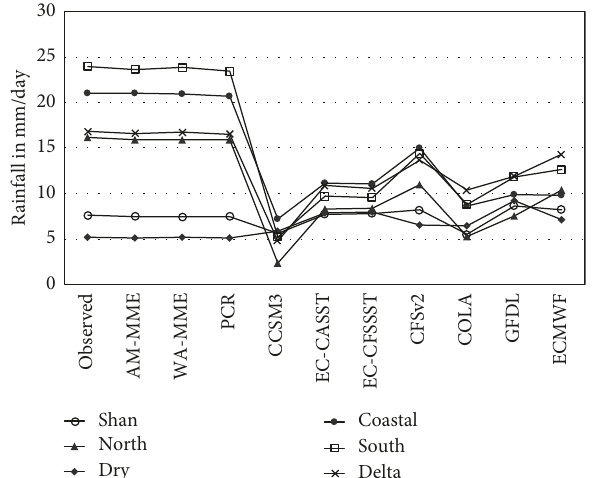
Figure 7: Observed and modeled rainfall during June to September period over the six climatological zones in